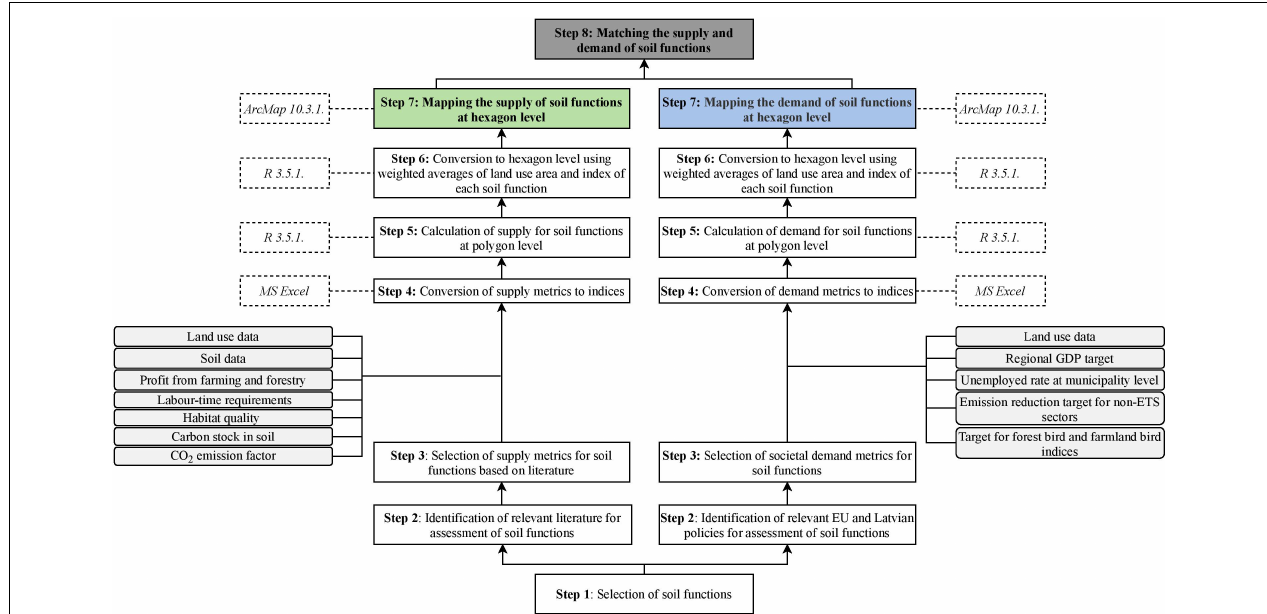
FIGURE 3 | Diagram of methodological steps followed to map the supply and demand of selected soil